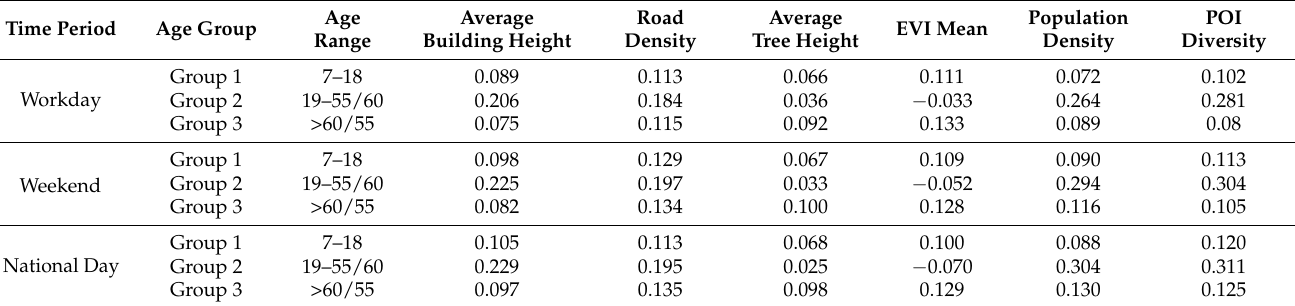
Table 2. The BMI values between recreation trips to parks and the built environment